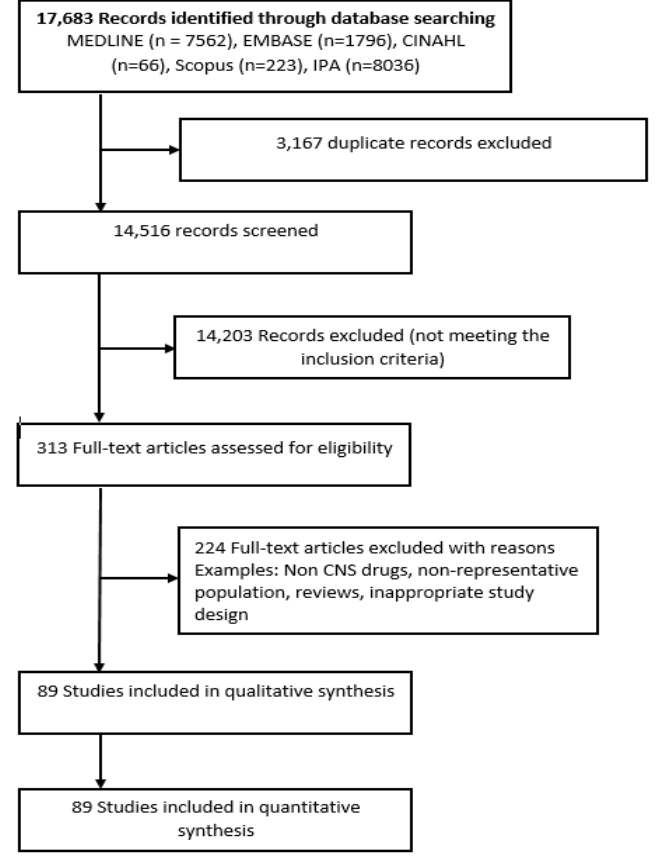
Figure 1. Study selection process (PRISMA).